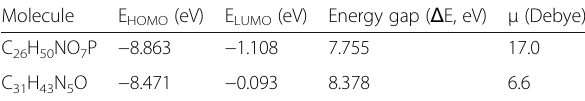
Table 6 Quantum calculation results of the APE obtained by using PM3 method